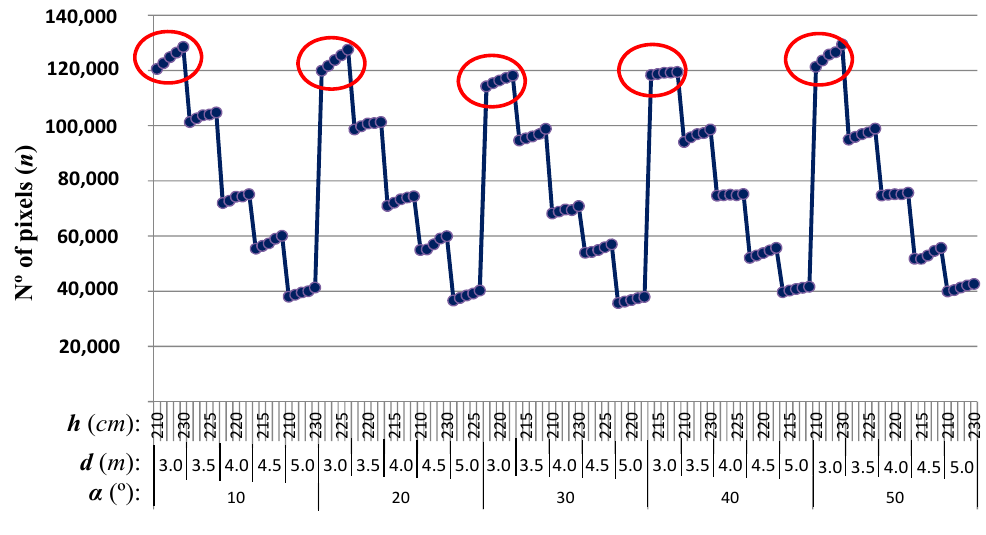
Figure 6. Dependency of the number of pixels ( n ) against h , d and α .